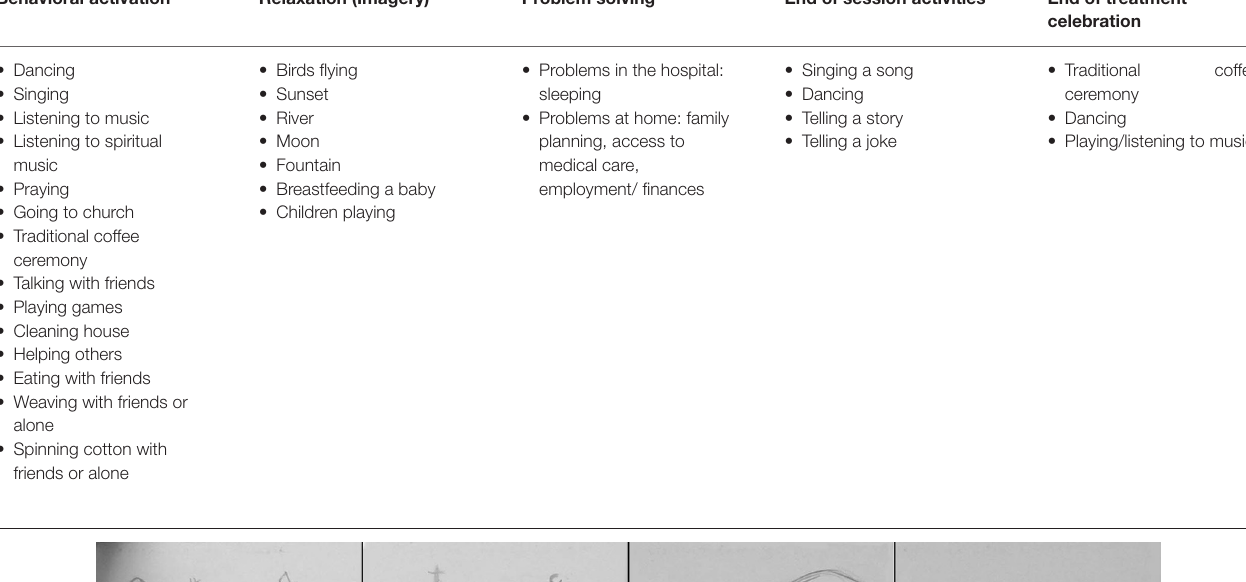
TABLE 2 | Cultural adaptations of behavioral activation, relaxation, problem solving, end of session activities, and celebration.